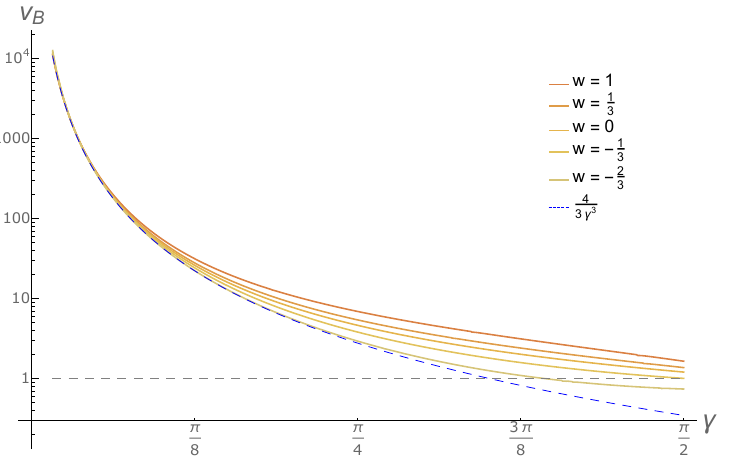
Figure 3 . Butter(cid:13)y velocity v B of a bulk local operator at the tip of the HRT surface, f = 0, as a function of the angular size (cid:13) of the leaf region for w = 1, 1 = 3, 0, (cid:0) 1 = 3, and (cid:0) 2 = 3 (solid curves, from top to bottom). The dashed curve represents v B = 4 = 3 (cid:13) 3 , the analytic result obtained for (cid:13) (cid:28) 1 in eq. (3.27). The horizontal dashed line represents the speed of